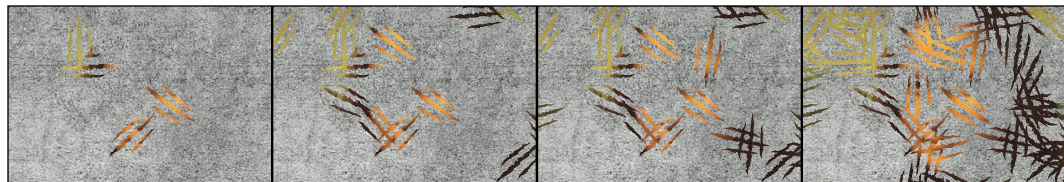
Figure 9. Some snapshots of the erasure animation as the number of valid shaking actions